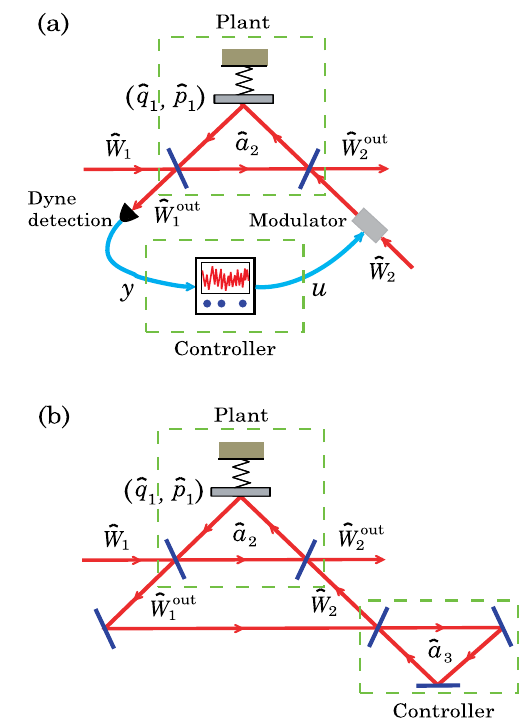
FIG. 1. Example of (a) measurement-based feedback and (b) coherent feedback, for cooling a mechanical